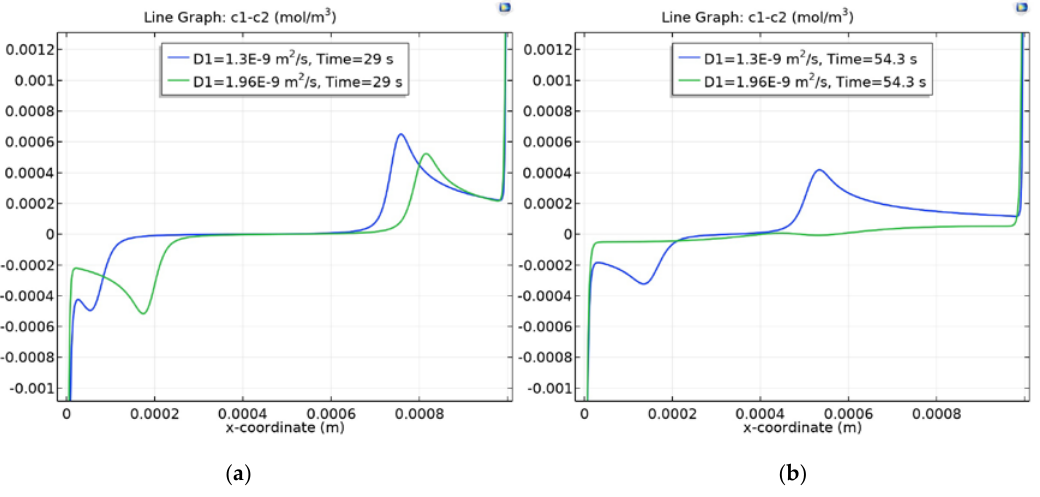
= 10 m/mol.C = . 29 t с ≈ ( a ); Figure 4. Graphs of the space charge at d = 0.1, C 0 = 0.1 mol / m 3 . t ≈ 29 c ( a ); t ≈ 68 c ( b ); t ≈ 82 c ( c ); , 0